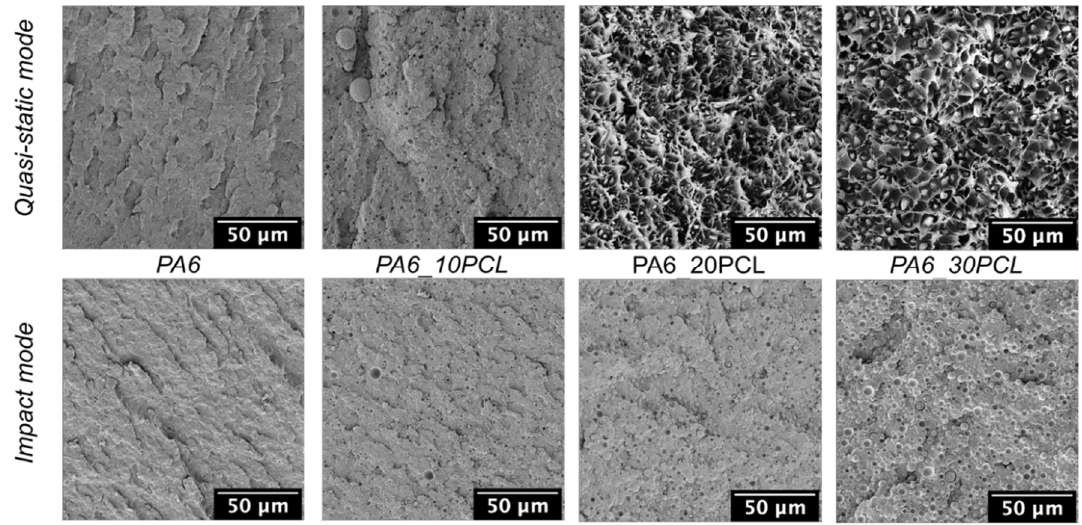
Figure 10. SEM micrographs of the SENB specimens of the blends tested in quasi-static mode and impact mode.